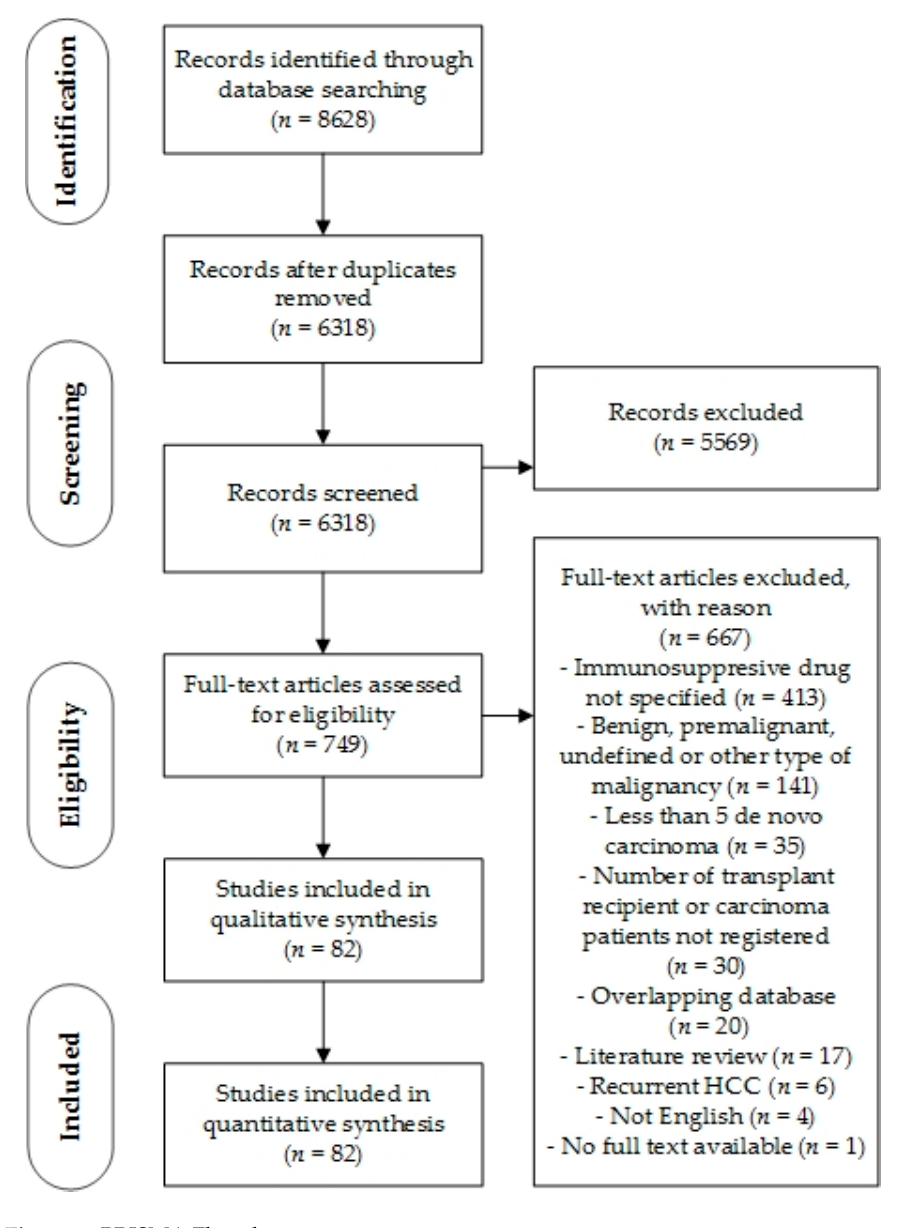
Figure 1. PRISMA Flowchart.